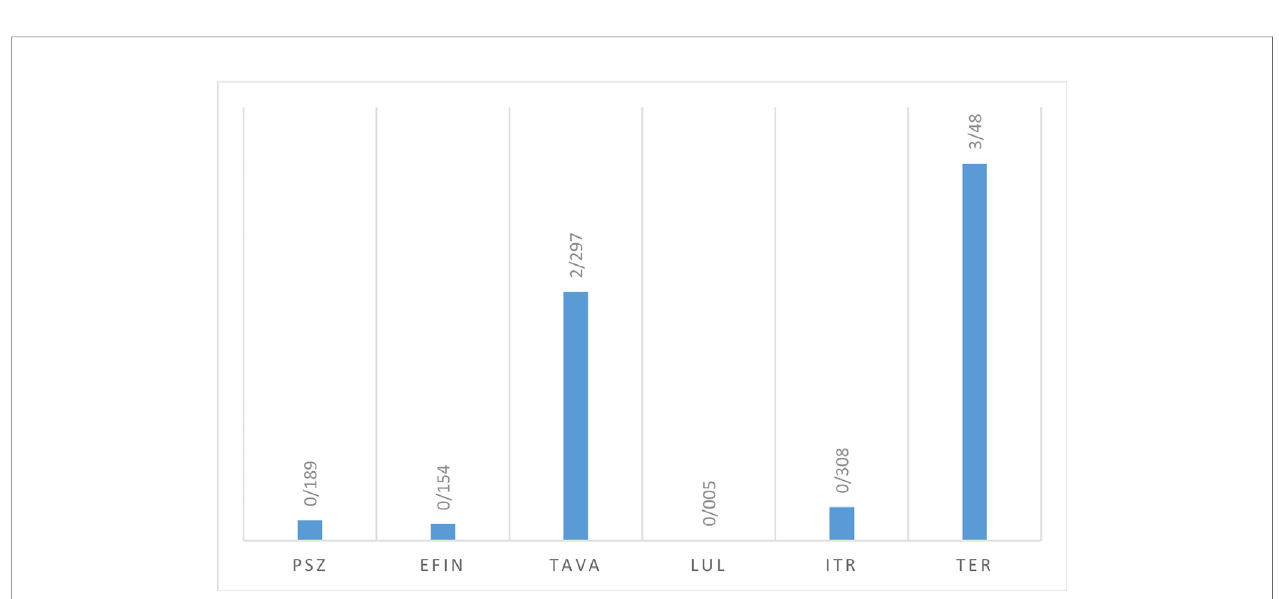
Frontiers in Cellular and Infection Microbiology |